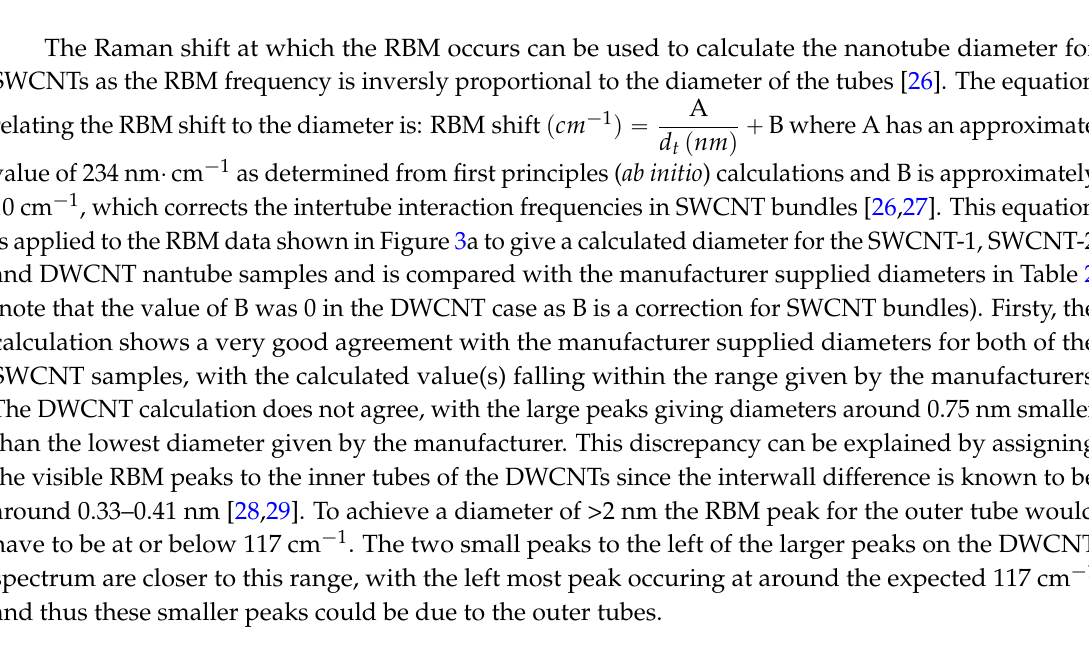
Table 2. Calculation of nanotube diameter from radial breathing mode (RBM) Raman shift.